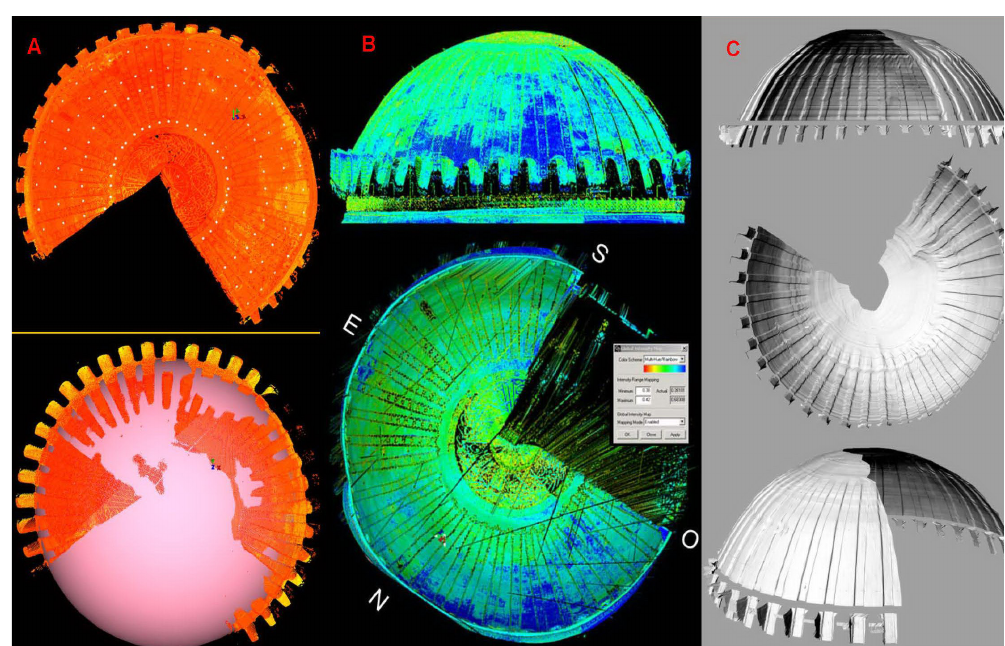
Fig. 13 Bianchini C., Haghia Sophia, surface interpolation, reflectance mapping, nurbs